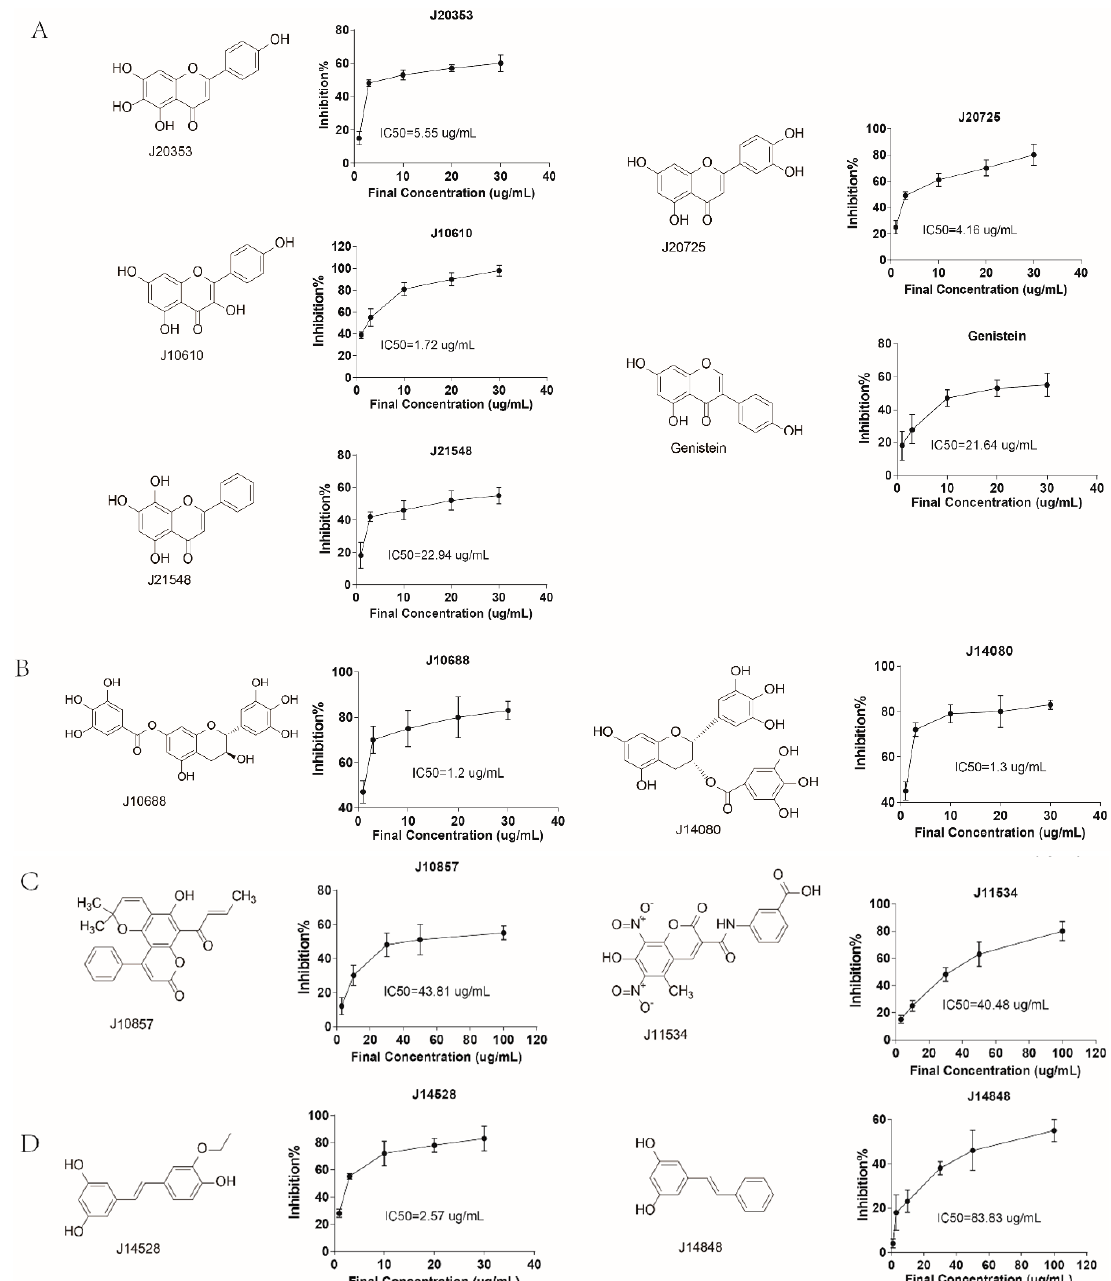
Figure 5. Virtual screening of lead compounds with CLK1 inhibitory effect. ( A ) Top five poses docking of ligand V25 in binding pocket of 2VAG, with RMSD value of 1.38 Å; ( B ) The interaction between ligand V25 and receptor is crucial for binding; ( C )The proportion of different levels of scores according to virtual screening.